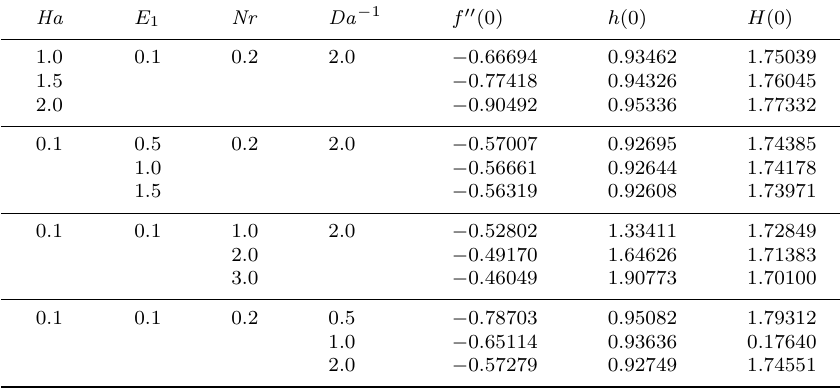
Table 3. Values of skin friction coefficient f (cid:48)(cid:48) (0), surface temperature h (0) and surface concentration H (0).